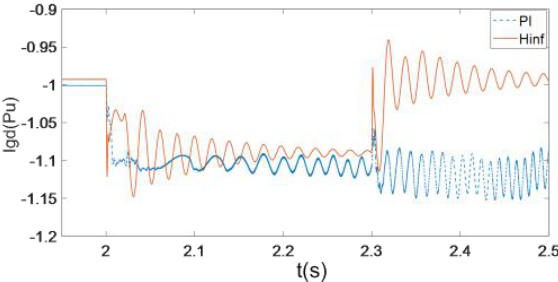
Figure 26. Current i gd in voltage drop condition.